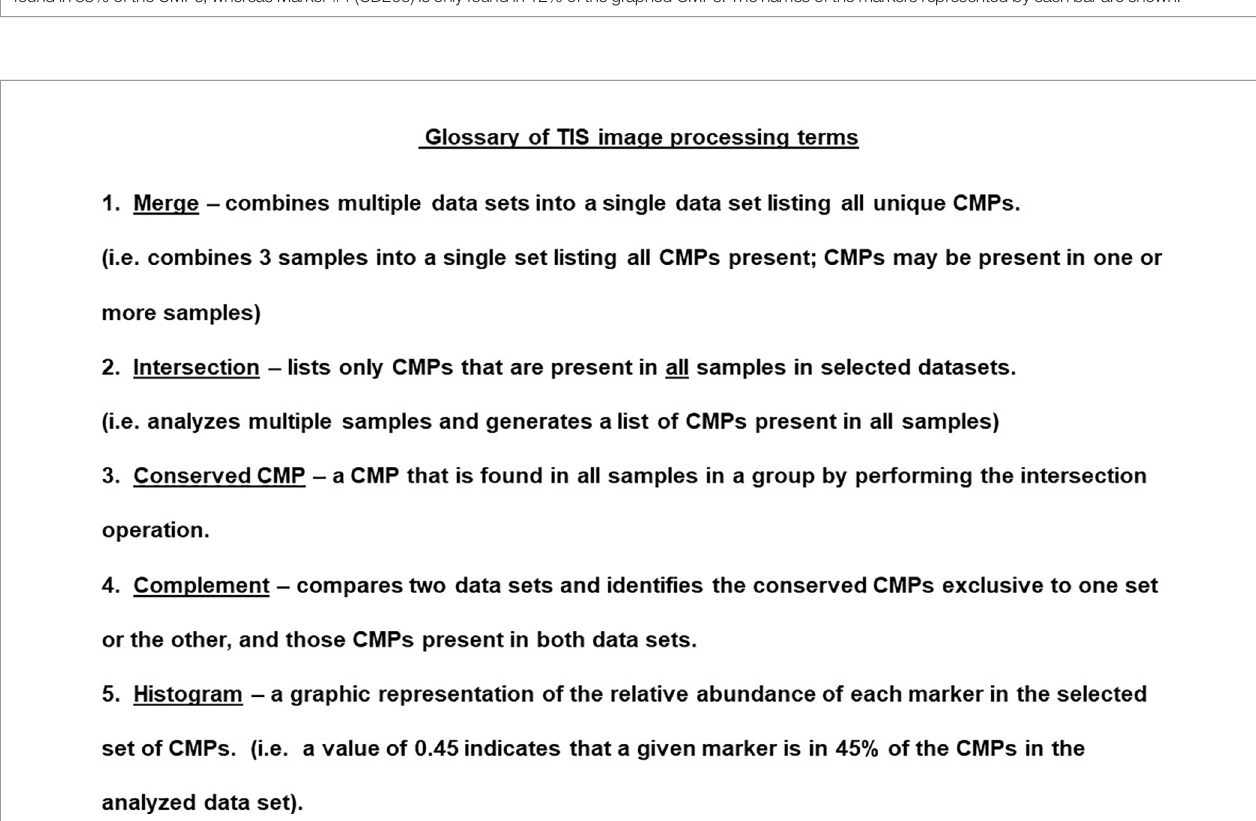
FIGURE 5 | Glossary of TIS terms. The TIS software enables probing the CMP data in a variety of ways. Several terms and the operations are listed and described in this fi